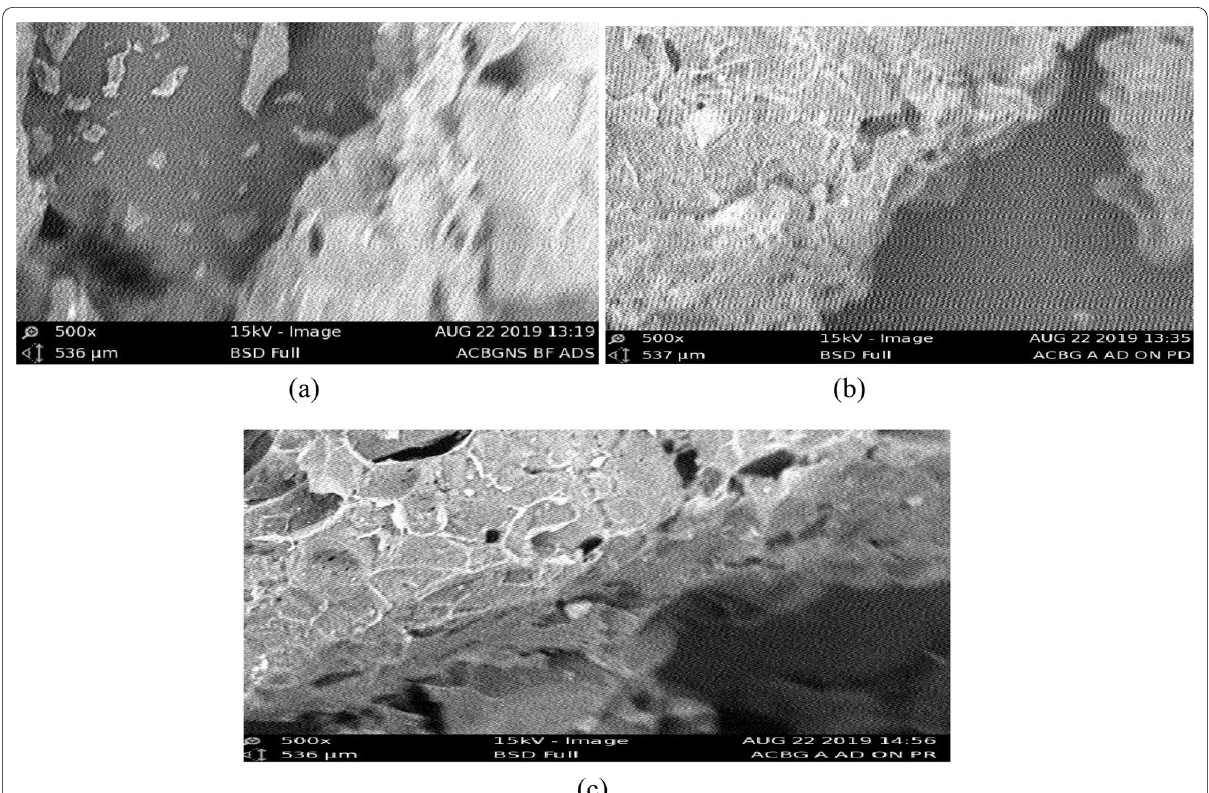
Fig. 2 SEM micrograph of ACBGNS ( a ) before adsorption and ( b ) after adsorption on PQ ( c ) after adsorption of PE. The adsorbent was characterized using scanning electron microscope (Phenom World Eindhoven). The SEM analysis was performed by scanning the micrographs of ACBGNS before and after adsorption using 15.00 kV voltage of acceleration with an